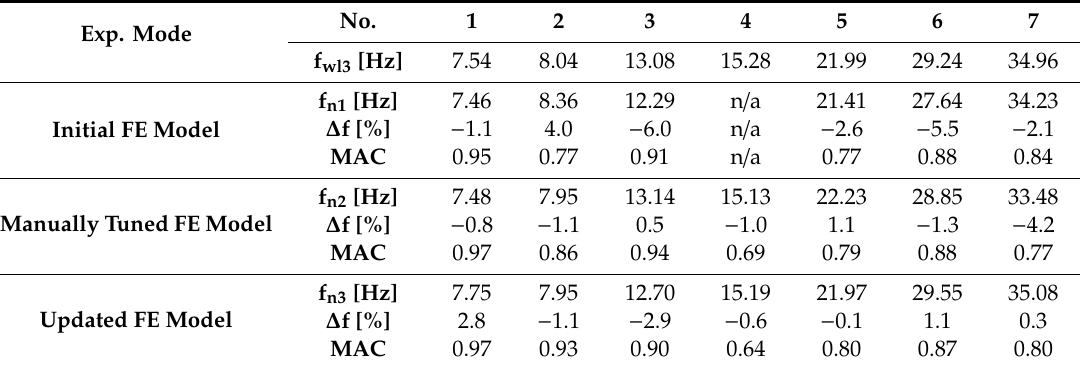
Table 3. Comparison of the experimental and numerical modal results.